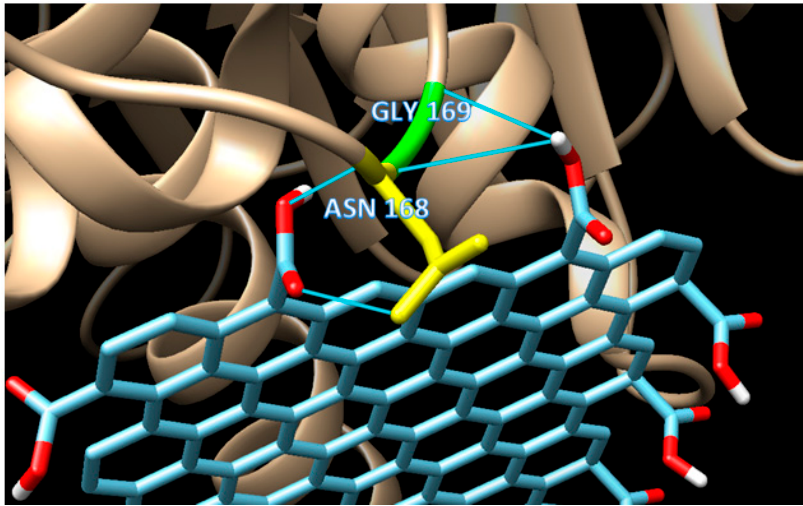
Figure 5. The detailed interactions of mode 3, which shows the occurrence of double H-bonds, one from GLY169 (H-bond distance of 3.149 Å), and one from ASN168 (H-bond distance of 2.859 Å).